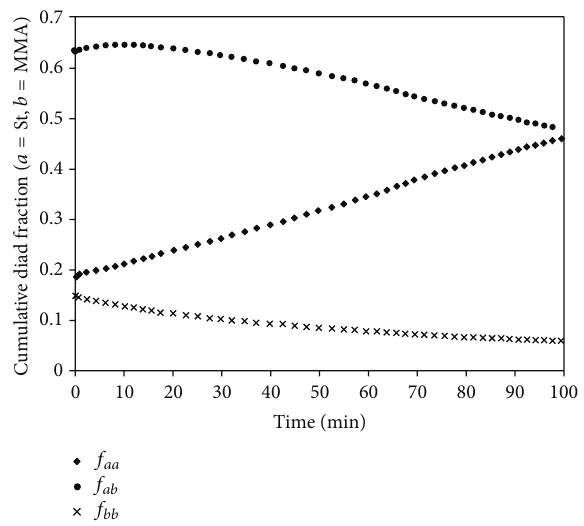
Figure 5: Cumulative diad fraction as a function of polymerization time for MMA-St copolymer. The initial monomers molar ratios are = 0.50 and 𝑓 = 0.50 . The full modeling parameters are 𝑓 0, MMA 0, st available in